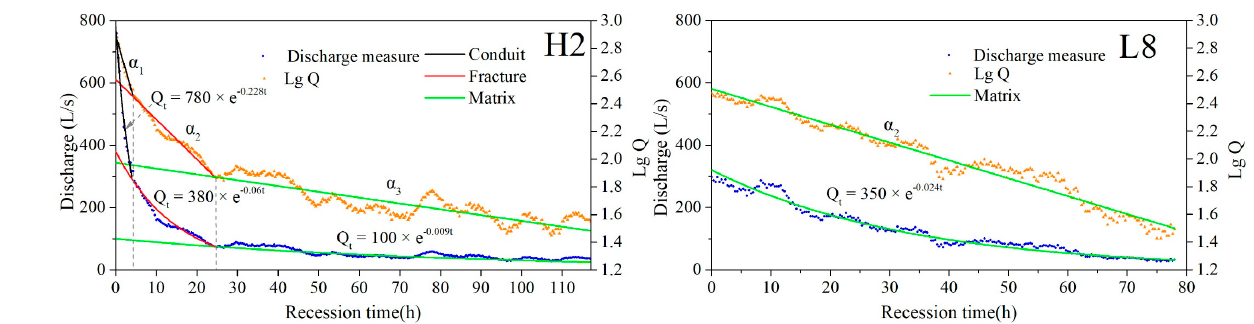
Figure 5. Recession analysis under two different rainfall patterns. Table 5. Ratio of water release from different Table 4. Recession coefficients under different rainfall conditions.